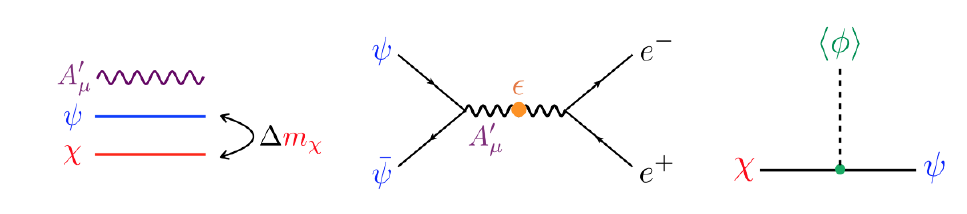
Figure 12 . Schematic representation of the model described in section 4. From left to right: mass spectrum, main annihilation channel, and mixing between DM, (cid:31) , and its coannihilating partner,